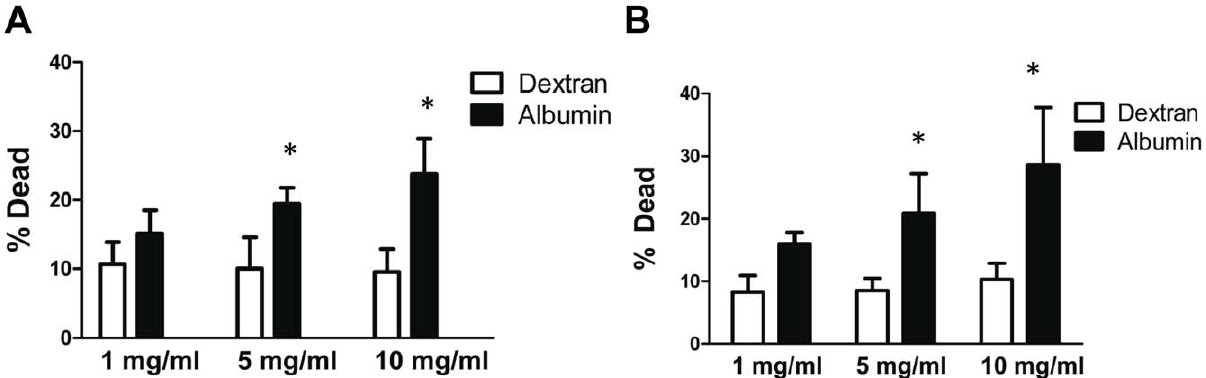
Figure 2. Albumin exposure increases cell death in podocytes. A , Cell death was measured using the trypan blue exclusion assay after treatment of podocytes with increasing doses of recombinant low-endotoxin human albumin (closed bars) or dextran of an equivalent molecular weight to albumin (open bars) for 24 hrs. * denotes P=0.0003 compared to corresponding dextran-treated cells. B , Cell death after treatment of podocytes with increasing doses of human albumin (closed bars) or dextran (open bars) for 48 hrs. * denotes P , 0.0001 compared to corresponding dextran-treated cells.